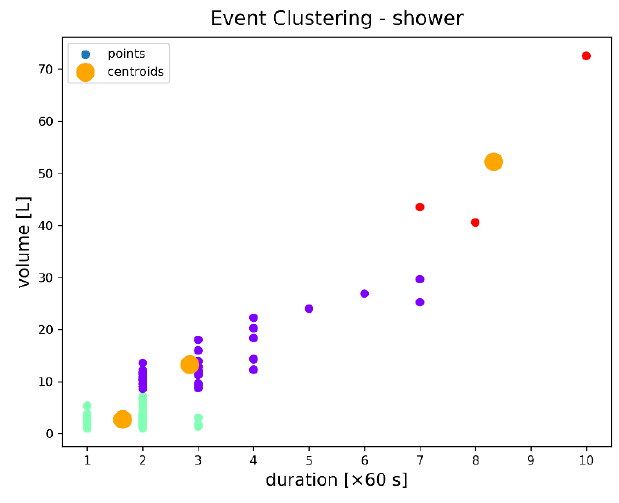
Figure 9. Consumption event clustering — shower.